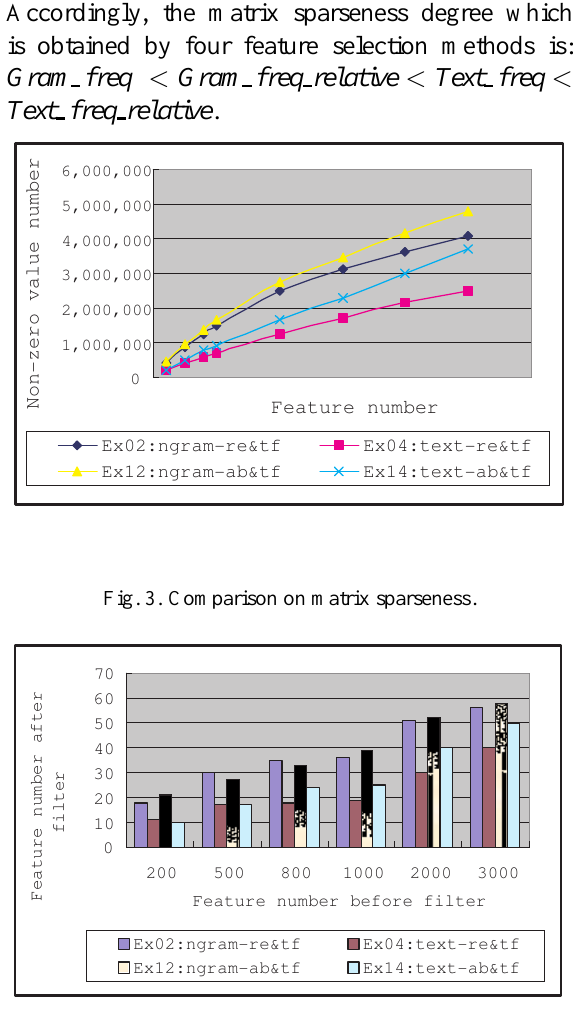
Fig. 4. Comparison on feature